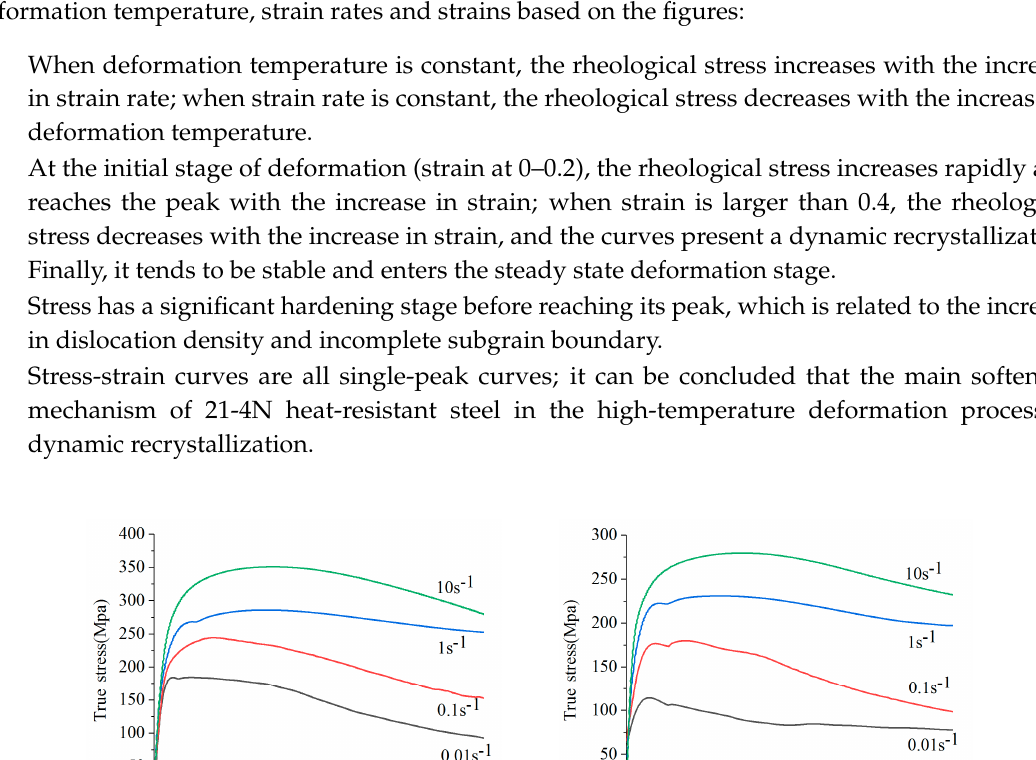
Figure 1. Experimental process.